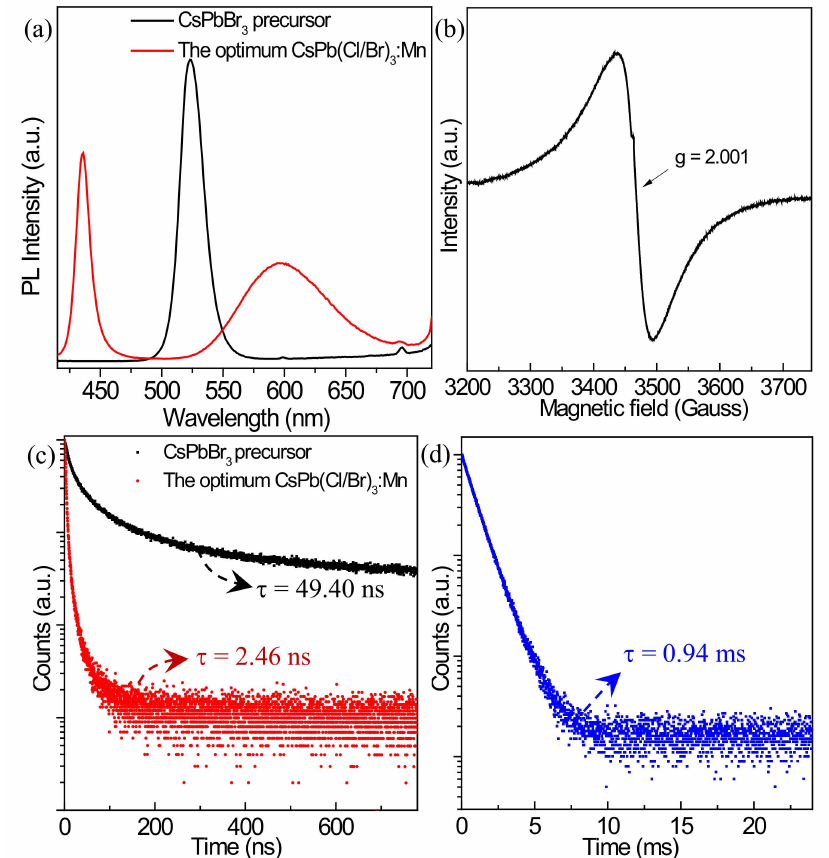
Figure 7. ( a ) PL emission spectra of the CsPbBr 3 precursor and the optimum CsPb(Cl/Br) 3 :Mn product. ( b ) EPR spectrum of the optimum CsPb(Cl/Br) 3 :Mn product. ( c ) PL decay curves of the CsPbBr 3 precursor and CsPb(Cl/Br) 3 :Mn detected at 523 and 437 nm, respectively, with 370 nm excitation. ( d ) PL decay curve of CsPb(Cl/Br) 3 :Mn detected at 597 nm with 370 nm